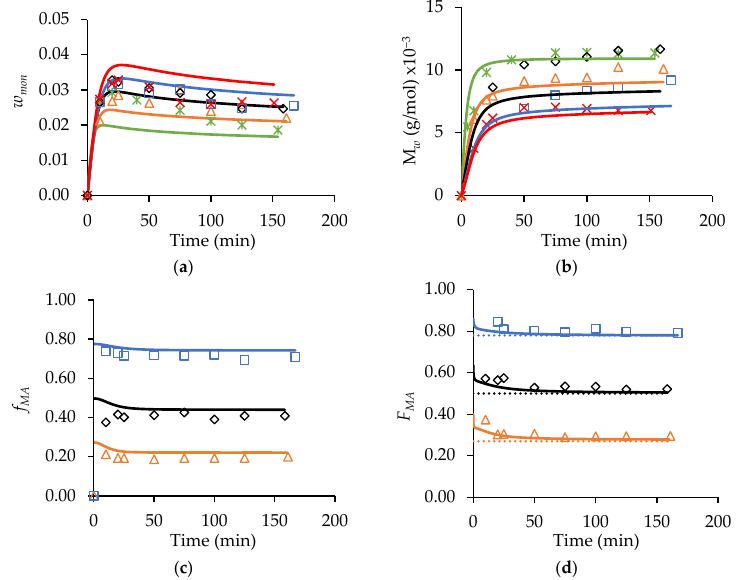
Figure 8. A comparison of experimental (symbols) and simulated (lines) profiles for ( a ) w mon , ( b ) polymer M w , ( c ) f MA , and ( d ) F MA from MA/t-BuAAm starved-feed semi-batch copolymerizations conducted at 70 °C, with w mon,total = 0.20, α EtOH = 0.75, 2.0 wt% AIBN, fed for 150 min with varying comonomer compositions in the feed: f MA, 0 = 0 ( ), f MA ,0 = 0.27 ( △ ), f MA ,0 = 0.50, ( ◇ ), f MA, 0 = 0.78 ( ☐ ), f MA, 0 = 1 ( × ). Simulations were conducted in PREDICI ® using the copolymerization model described in [14]; see also Tables S2 and S3. Dotted lines in the F MA profile correspond to the feed composition (i.e., f MA, 0 ) of the starved-feed semi-batch reactions.